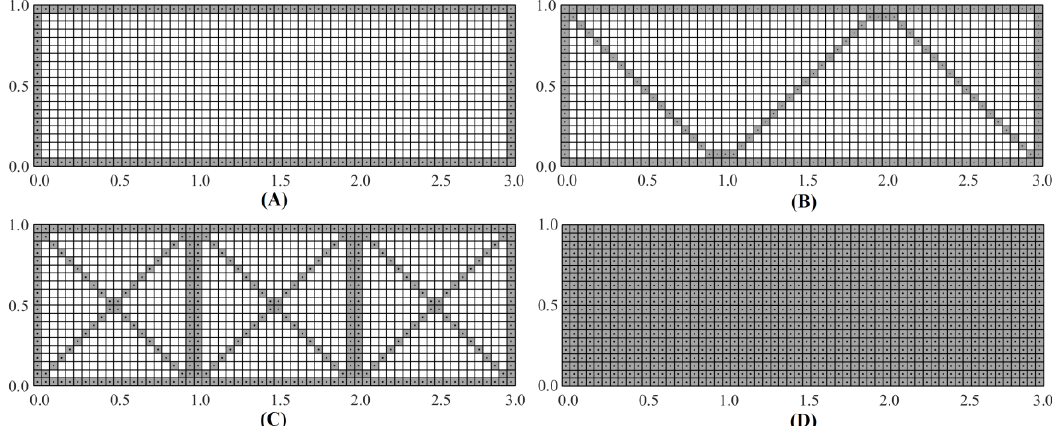
Figure 4. Sensor configurations for the iQS4 mesh; Configuration: ( A ) with strain sensors along the boundaries; ( B ) with strain sensor along diagonal paths arranged in a zig-zag pattern; ( C ) with sensors along cross-diagonal paths; and ( D ) with sensors placed at the centroids of all elements.